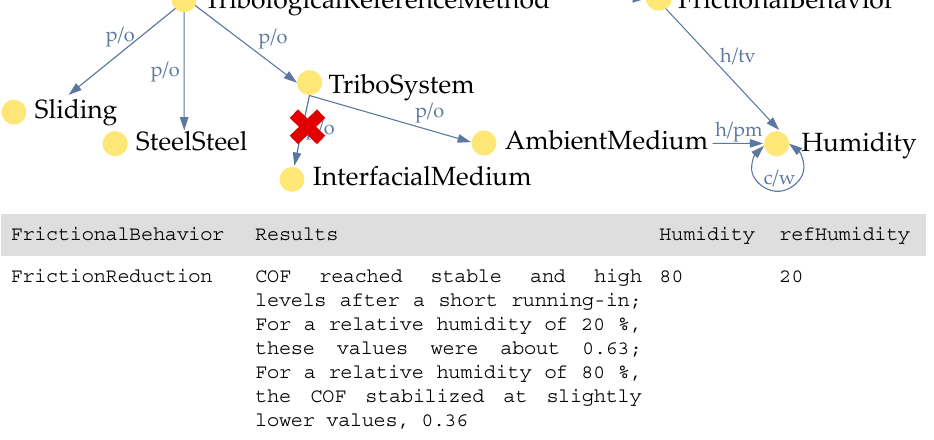
Figure 14. Graphical example of the formulated query filter and example output for research question (1).